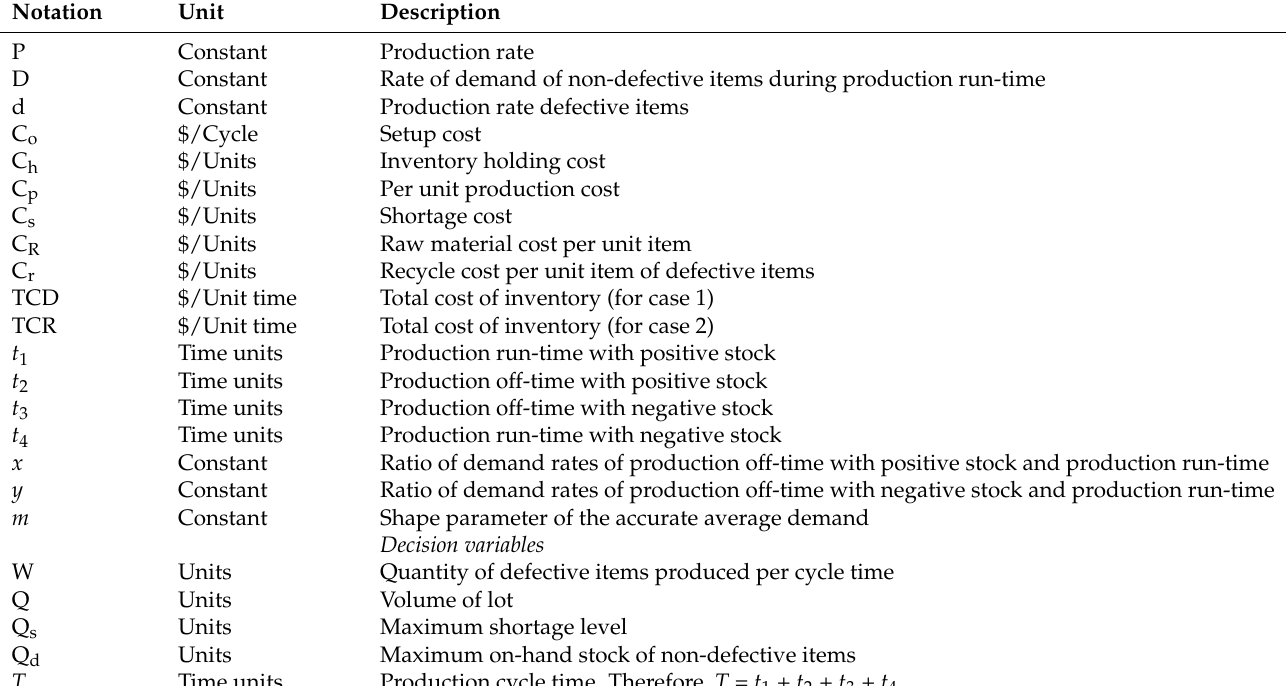
Table 1. Notation used in the model.